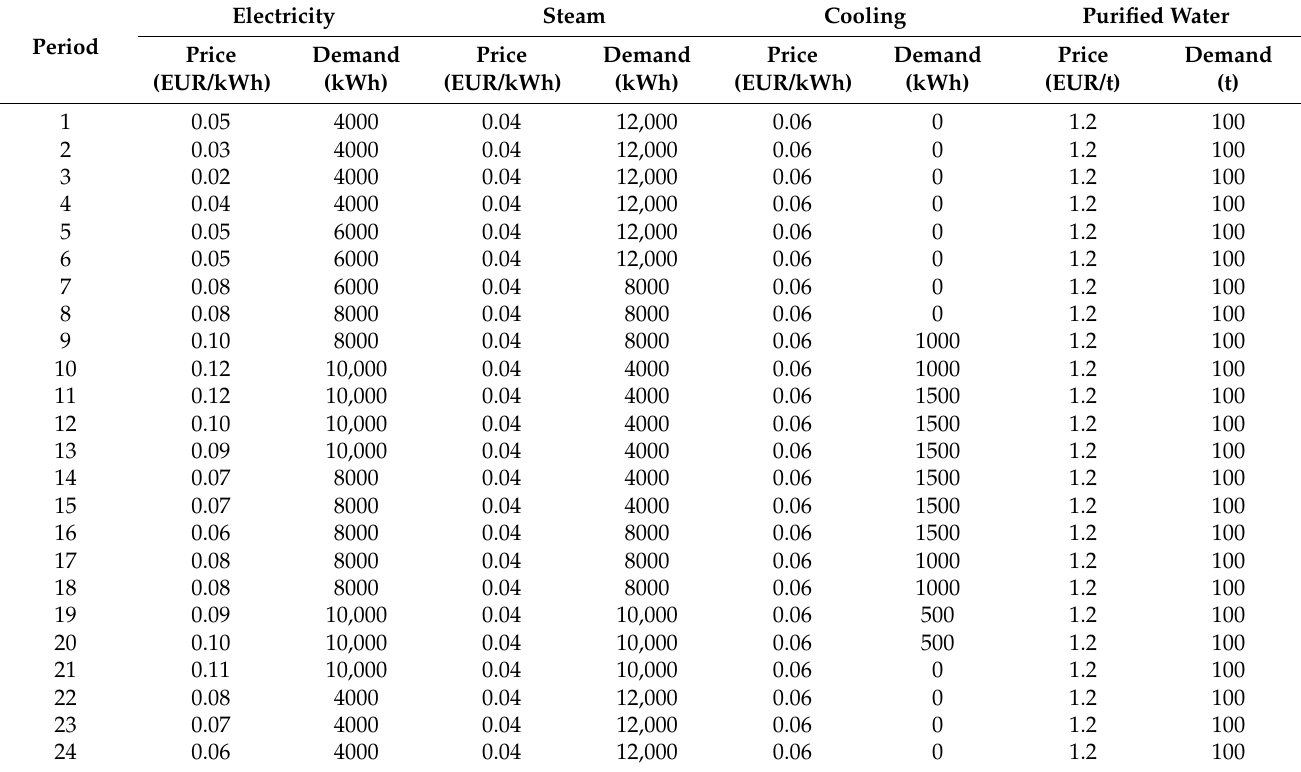
Table 4. Parameters of price and demand for materials involved in case study of 24